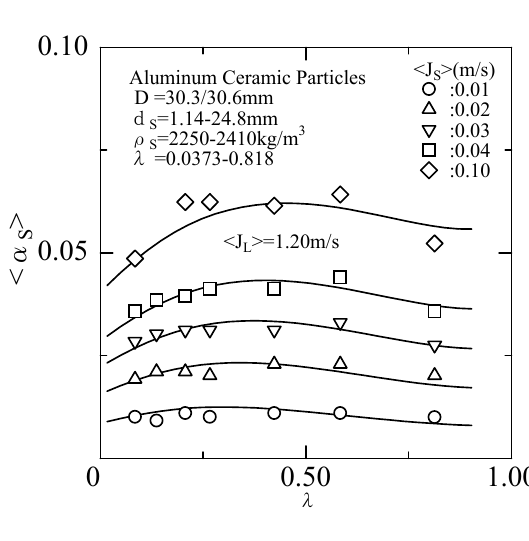
Fig.2 Solid volume fraction of solid-liquid two-phase flow with respect to